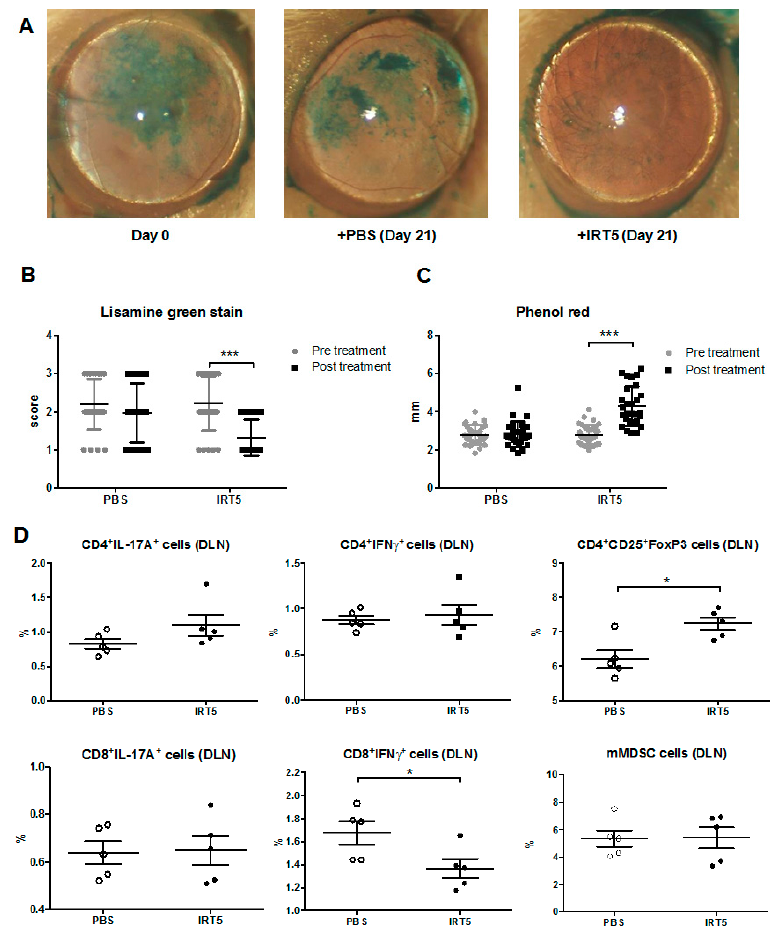
Figure 2. IRT-5 treatment reduces clinical manifestations of autoimmune dry eye model. ( A ) One set